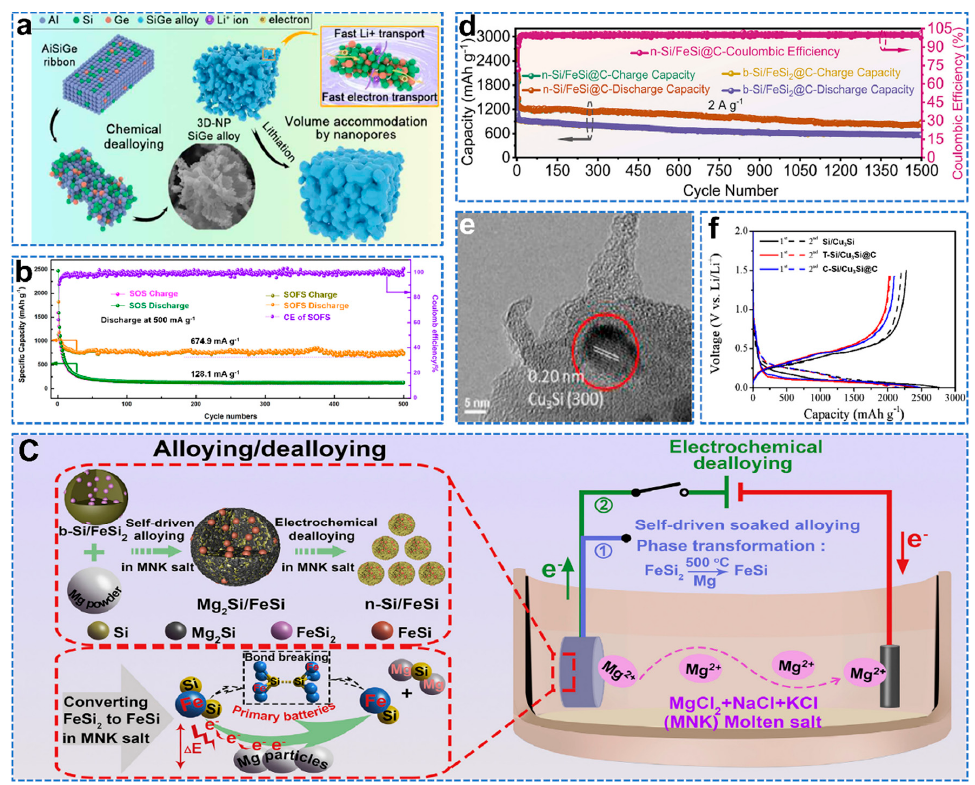
Figure 5. ( a ) Schematic of the evolution of 3D − NP SiGe structure via chemical dealloying [51]. ( b )